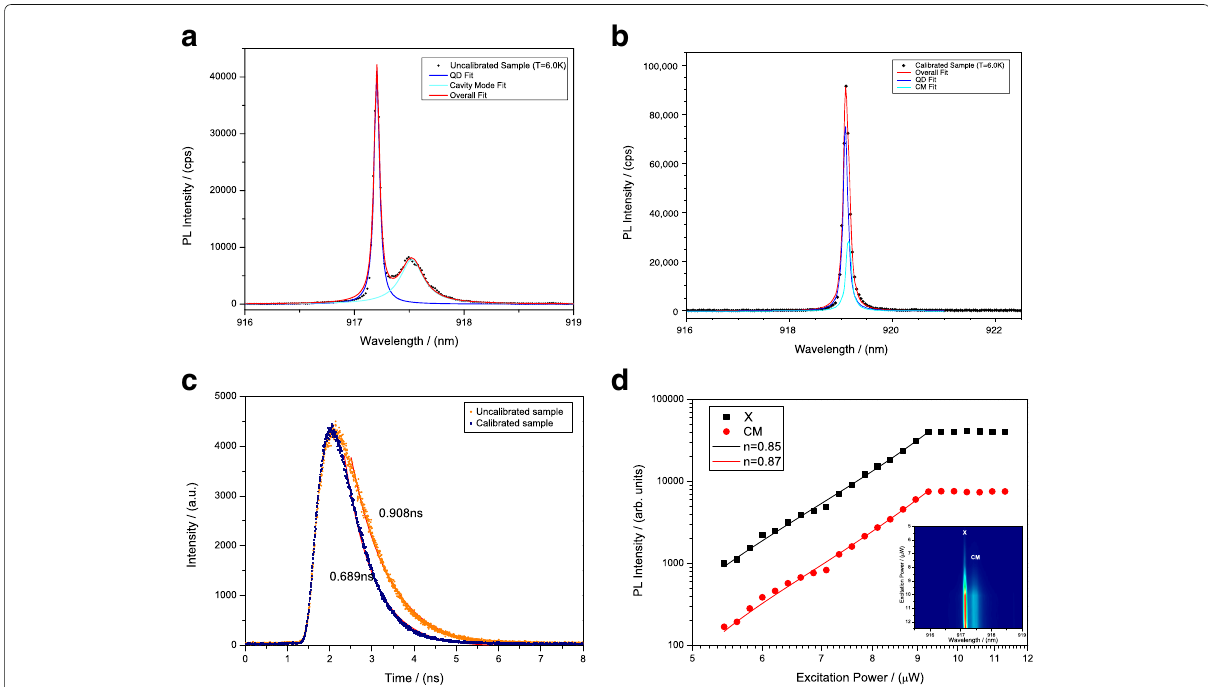
Fig. 2 a μ PL spectra of the QD exciton of the uncalibrated sample at 6.0 K with the exciton (X) line and the cavity mode (CM) line. b μ PL spectra of the QD exciton of the calibrated sample at 6.0 K. Colored lines: Lorentz fitting of the experimental data. c Time-resolved measurements of uncalibrated sample and the calibrated sample at 6.0 K. d Excitation power-dependent μ PL spectra of the uncalibrated sample at 6.0 K; inset: integrated PL intensity of X and CM as a function of excitation power in a log-log